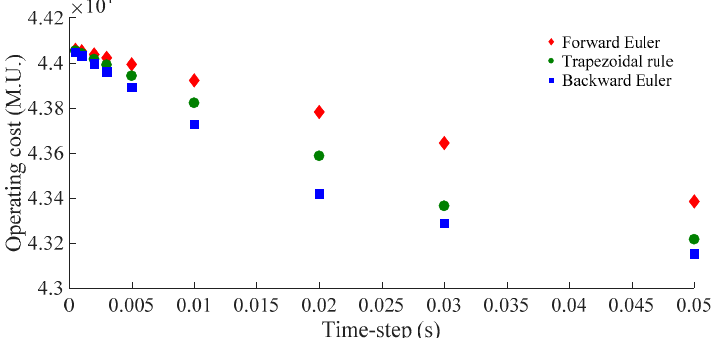
Figure 4. TSCOPF result for the short-circuit at bus 16, obtained using different numerical integration methods and time steps.